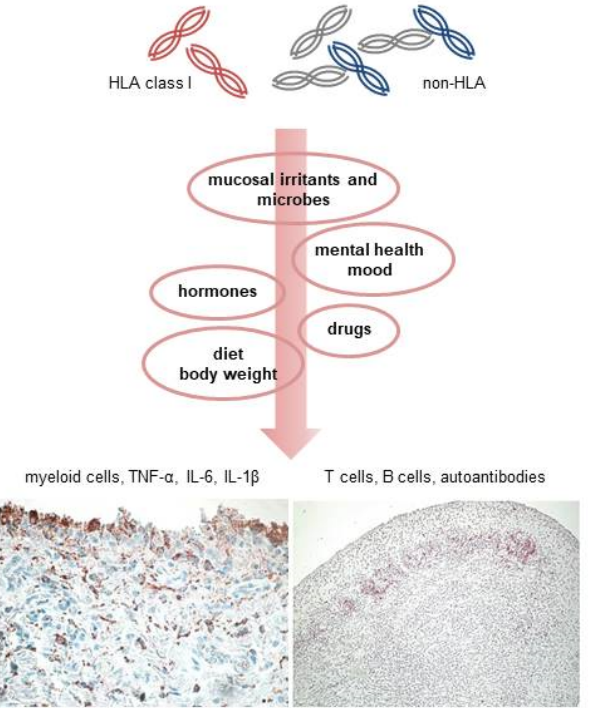
Figure 1. Proposed model of disease pathogenesis in autoantibody-negative rheumatoid arthritis. The genetic susceptibility risk of autoantibody-negative rheumatoid arthritis mostly relies on class I HLA genes and a number of yet unidentified non-HLA loci. On the back- ground of variable genetic predisposition, multiple exogeneous, endogenous, and sto- chastic factors contribute to the onset of the inflammatory cascade. These include, but are not limited to, inflammatory and microbial stimuli at mucosal sites, dietary factors and excess body weight, hormonal factors, mental health, and medications. In a proportion of the patients, the immunopathology of synovitis, at least in the initial stages, appears largely myeloid driven, with an abundant production of proinflammatory cytokines and only minor involvement of cells of the adaptive immune system. However, T and B cells can infiltrate the synovial tissue, and autoantibody production may also occur.